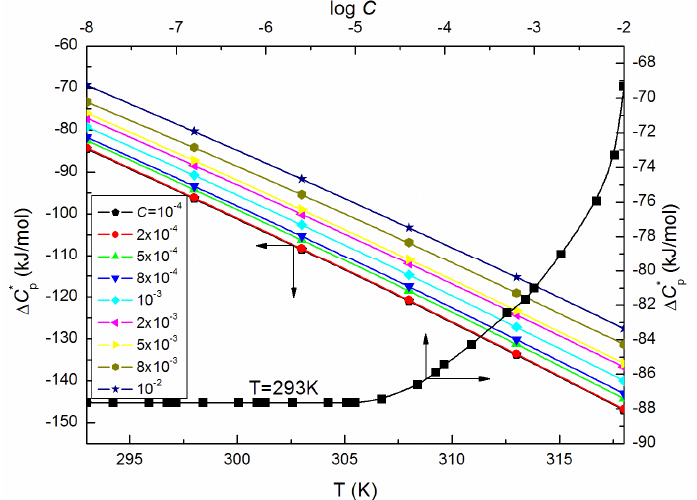
Figure 5. A plot of the values of the enthalpy of activation ( ∆ H ∗ ) of the aqueous solutions of ELP at C from 10 − 4 to 10 − 2 M vs. the temperature, T, as well as the values of ∆ H ∗ of the aqueous solutions of ELP at T = 293 K vs. log C .